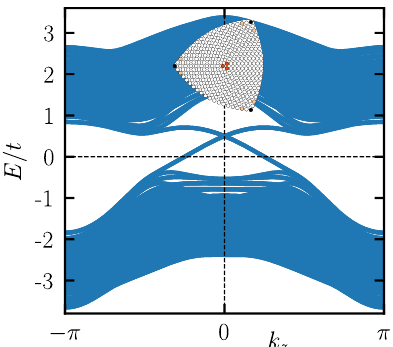
Figure 16: Bandstructure of a 3D second-order topological insulator in class AII pro- tected by fourfold symmetry as defined in Eq. (18): the model is realized in a pillar geometry with a line disclination parallel to the z axis. The inset shows the real-space = weight of the electronic in-gap states at k z